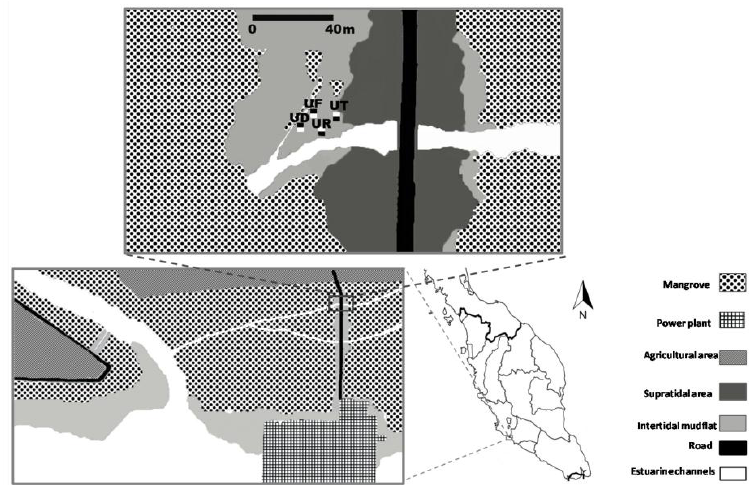
Figure 1. The approximate locations of the U. paradussumieri (UD), U. forcipata (UF), U. rosea (UR) and U. triangularis (UT) sampling plots. Burrowed and non-burrowed sediments are indicated by filled ( ■ ) and open (□) squares respectively.